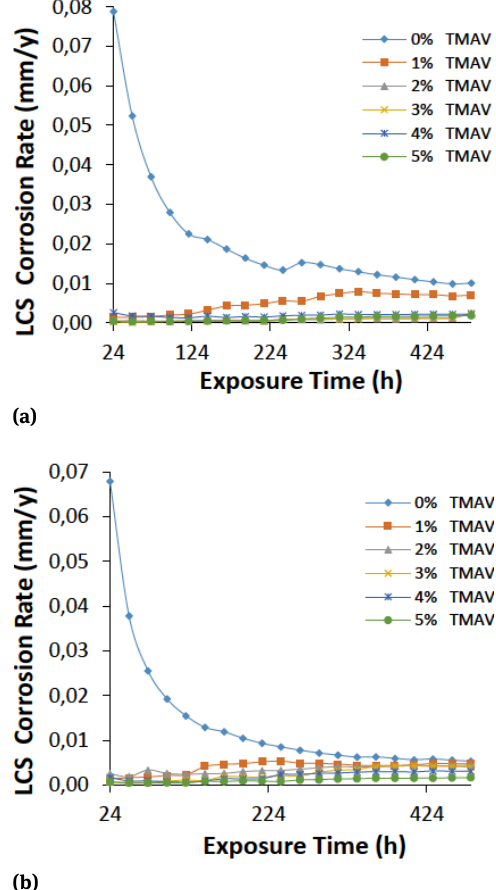
Figure 5: Plot of LCS corrosion rate versus exposure time at 0% – 5% TMAV concentration in (a) H 2 SO 4 and (b) HCl